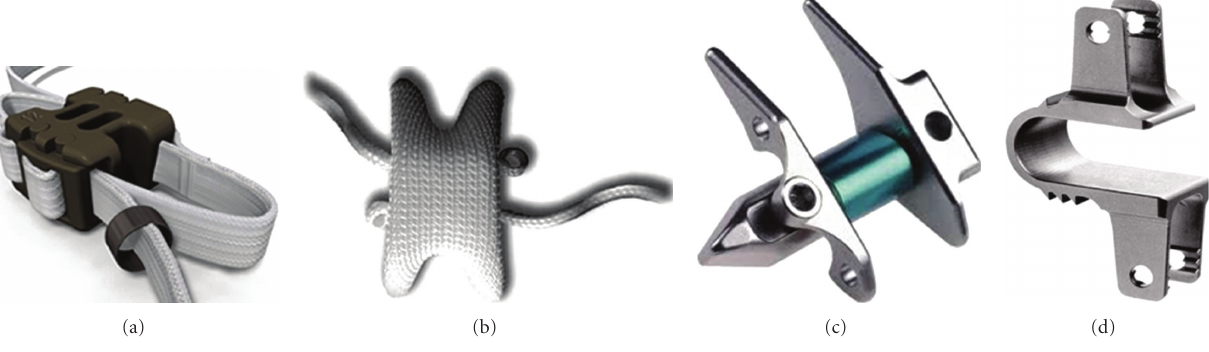
Figure 10: Interspinous spacers. (a) Wallis system; (b) DIAM system; (c) X-stop; (d) Coflex